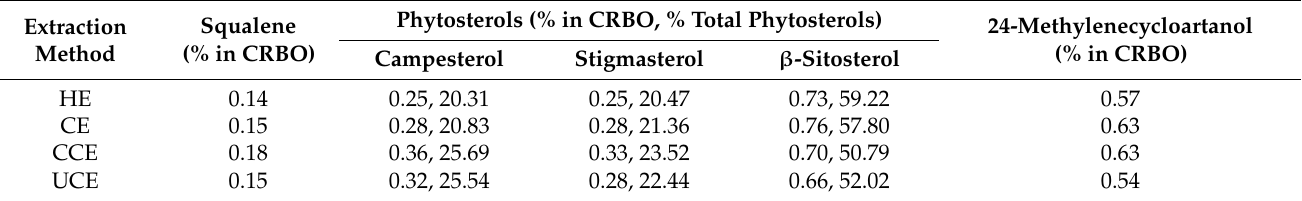
Table 4. GC–MS relative percentage composition of squalene, phytosterols, and triterpenoid in CRBO.